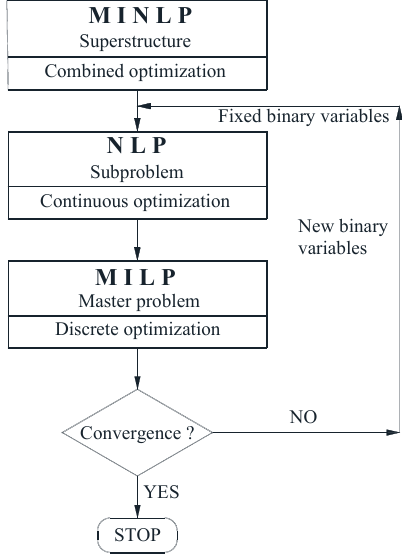
Figure 4. Steps of the OA/ER algorithm.